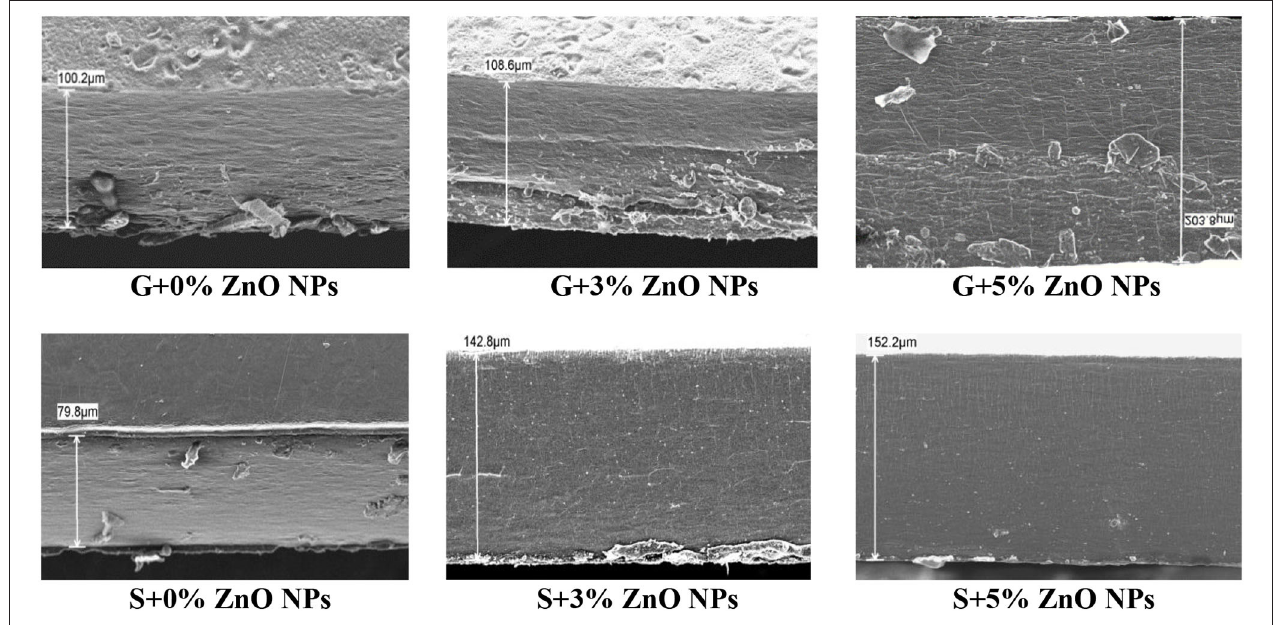
FIGURE 2 | SEM micrographs of bionanocomposite